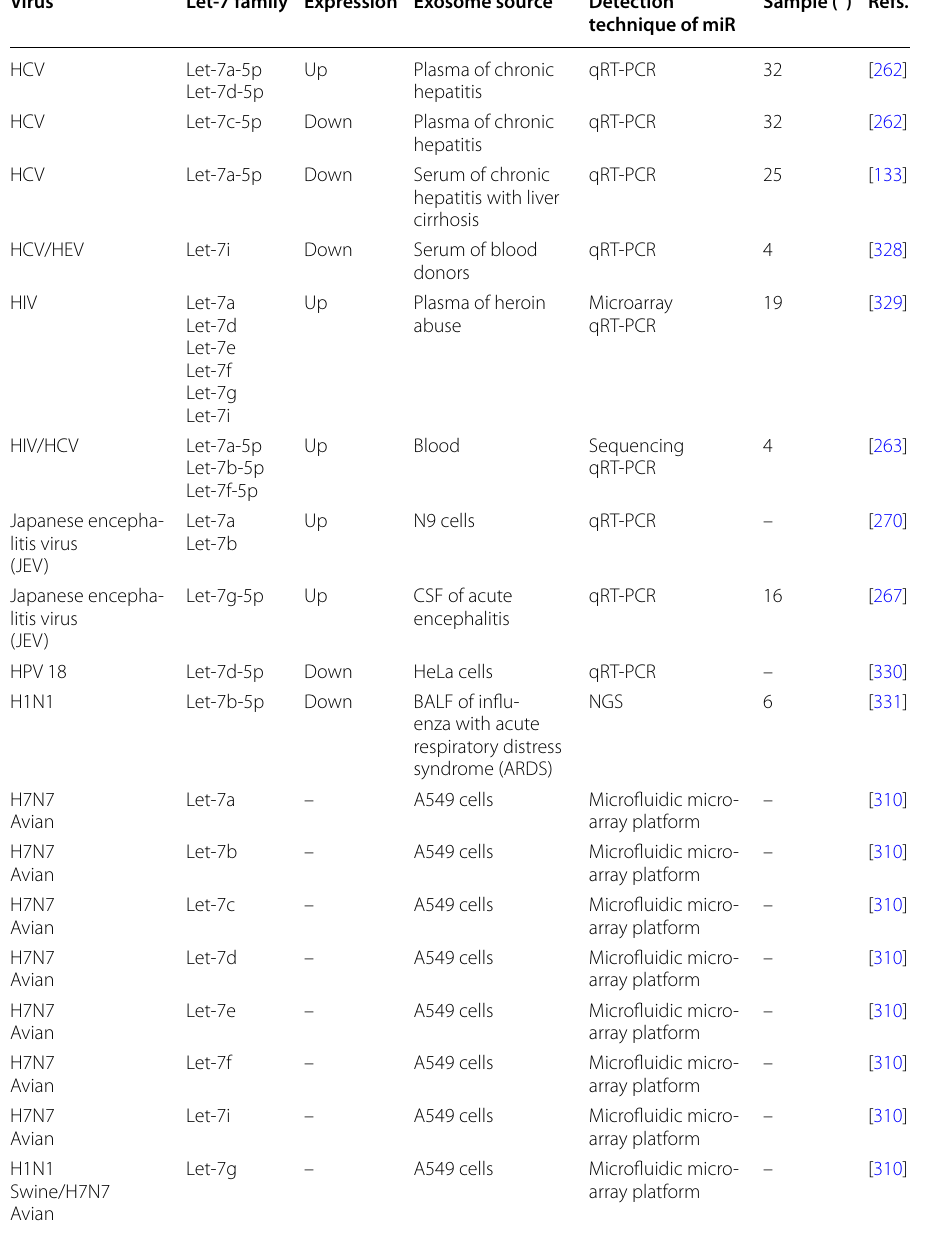
Table 3 Exosomes containing let‑7 family members in viral infections Virus Let-7 family Expression Exosome source Detection